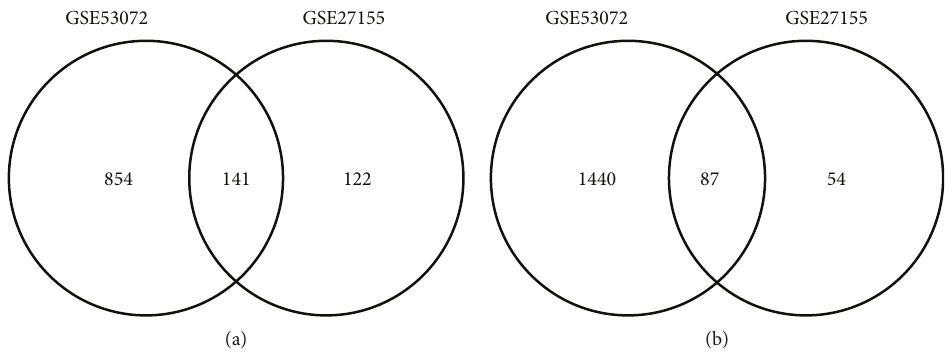
Figure 1: Venn diagrams showing the number of di ff erentially expressed genes (DEGs) in ATC tissues compared with normal thyroid tissues ((a) the number of upregulated genes; (b) the number of downregulated